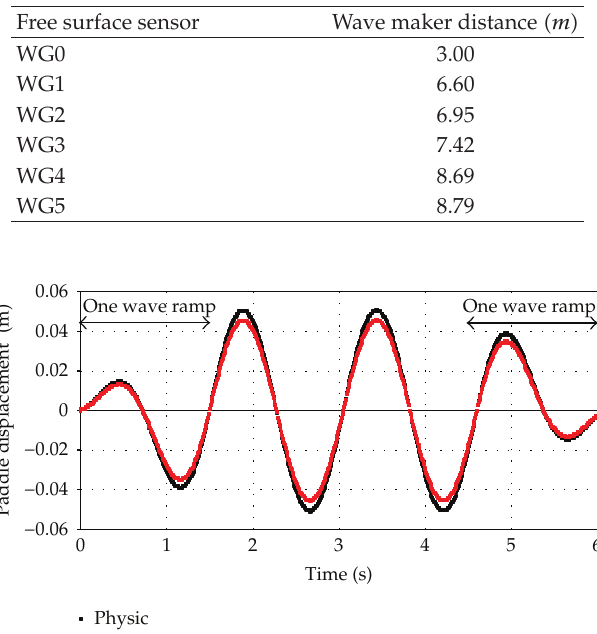
Table 2: Free-surface sensor positions (cid:2) see Figure 1 (cid:3) .